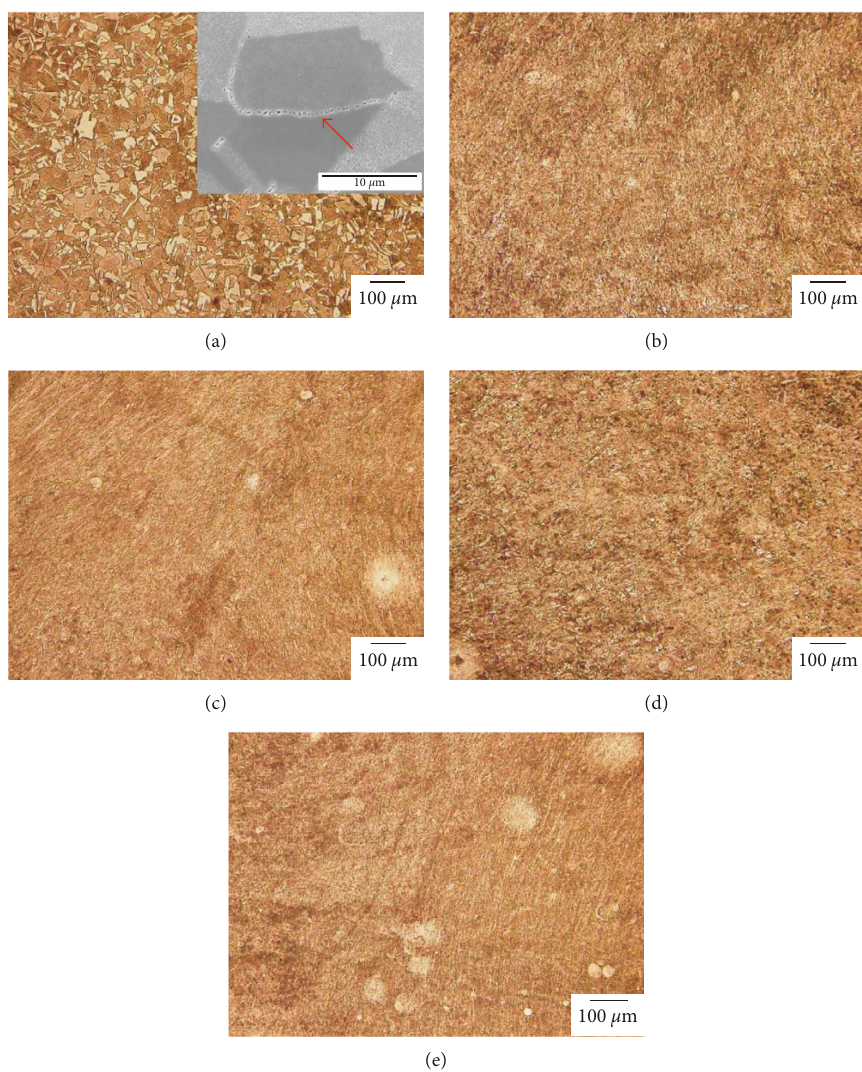
Figure 5: Dissolution surface morphology of samples: (a) as-annealed and (b) two, (c) four, (d) eight, and (e) twelve SSE